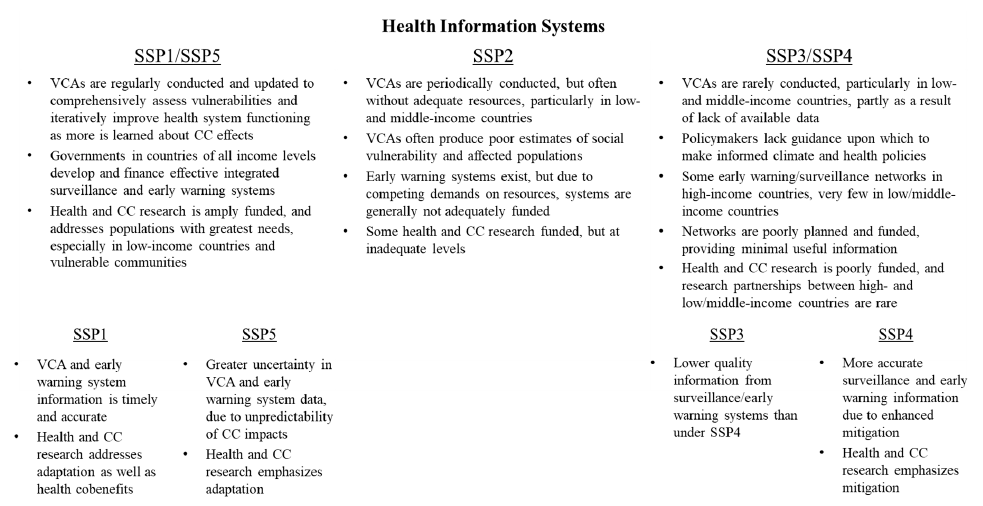
Figure 5. Variation in health information systems across SSPs.